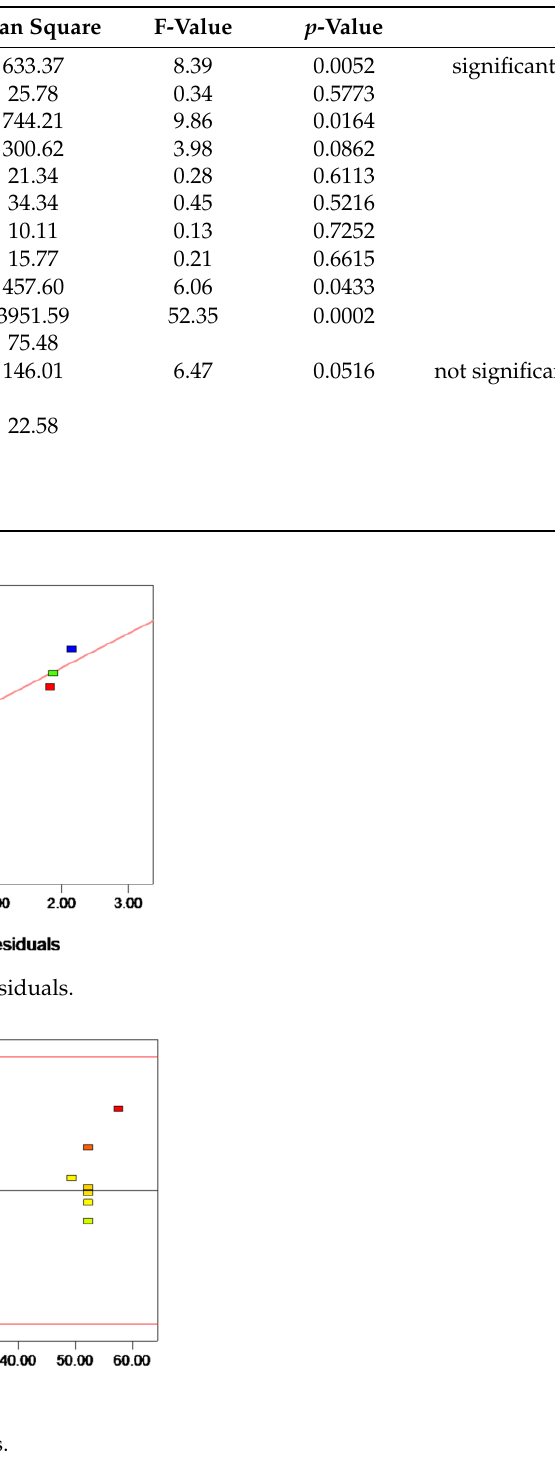
Figure 7. Actual values vs. predicted values. The 3D response surface and contour plots are given in Figures 8 – 10. The nonlinear nature of the presented 3D surfaces and contour plots clearly shows considerable interac- tions among the studied process parameters [36]. Figure 8 showed that the change in mag- netite dosage did not significantly affect the height of the surface, which meant that mag- netite dosage had little effect on BPA degradation. In Figure 9, the variation in pH value caused the deformation of the curved surface more than the variation in PS concentration, indicating that the effect of pH on the degradation of BPA was greater than that of PS. As can be seen in Figure 10, the effect of pH on BPA degradation was significantly higher than that of magnetite dosage. Therefore, the factors affecting the degradation of BPA are as follows, according to their importance: pH, persulfate concentration, and magnetite dosage.